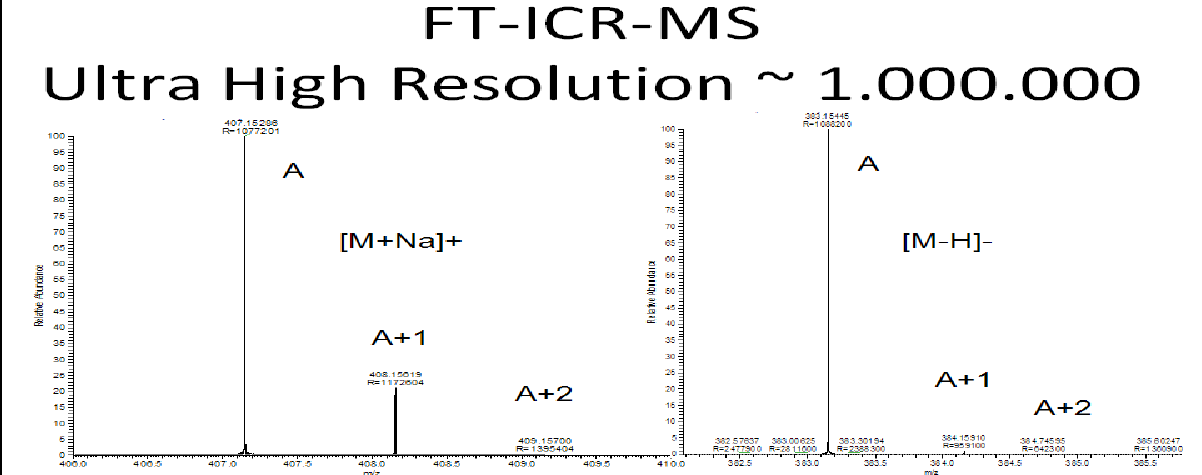
Figure 13. A high-resolution spectra of a potential predictor, m/z 407.1527 at positive mode [M+Na] + and m/z 383.1545 at negative mode [M-H] - , illustrating isotopic pattern at 1,000,000 resolution using LTQ FT Ultra